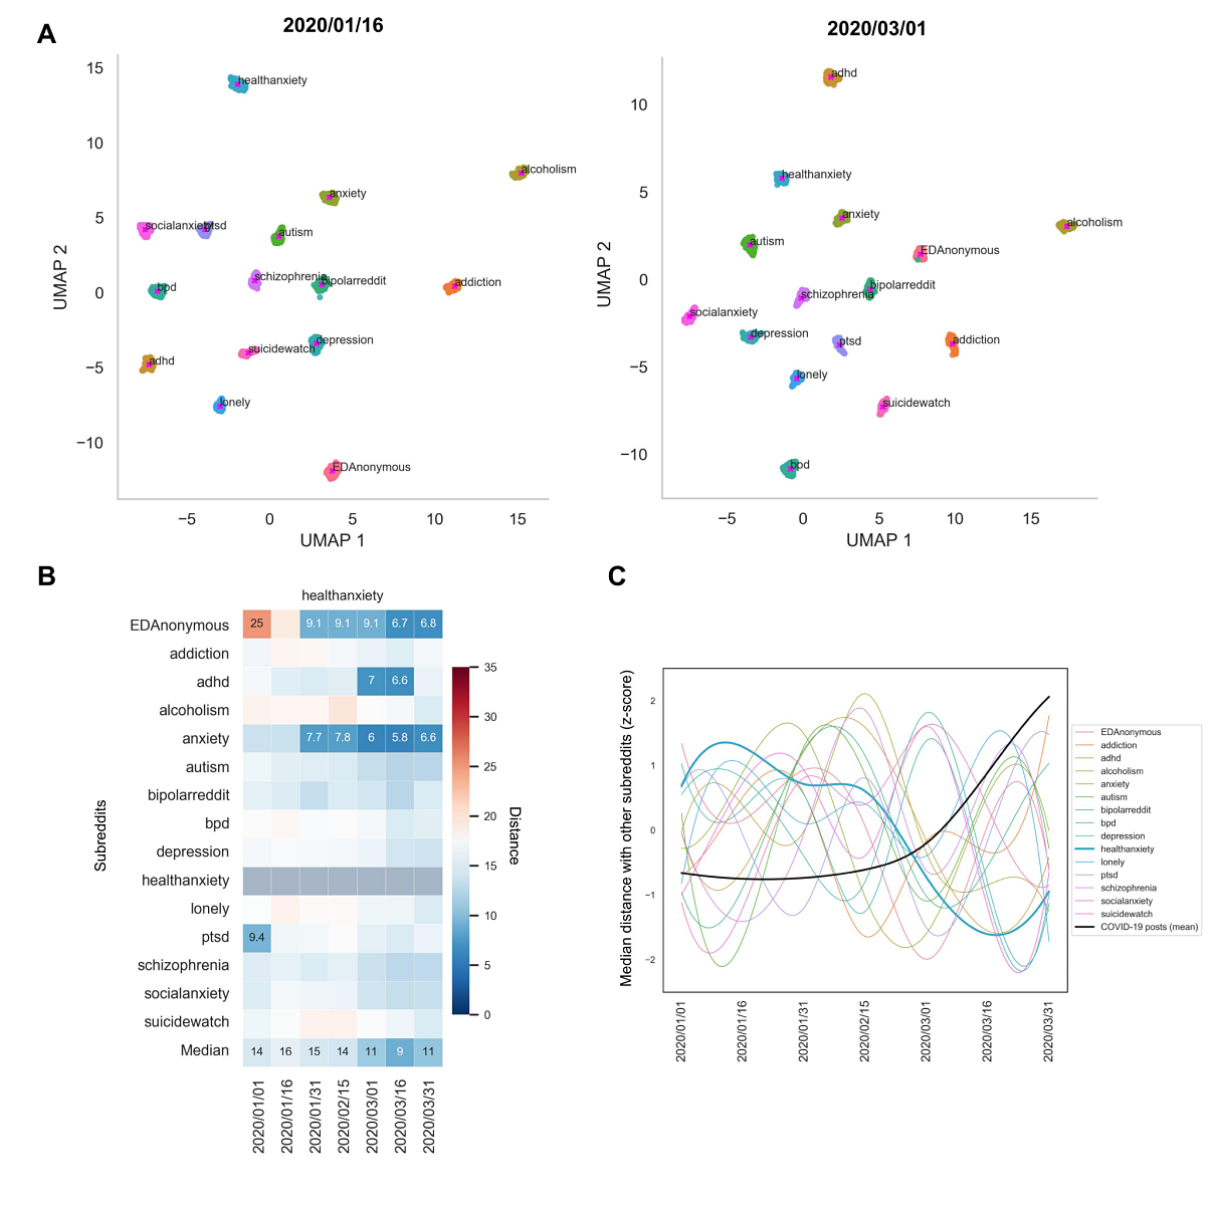
Figure 6. Supervised dimensionality reduction to measure how certain subreddits are becoming more or less similar over time. A) Supervised dimensionality reduction of posts within 15-day time windows with starting day displayed (r/healthanxiety becomes more similar to other subreddits). B) Median pairwise distance with r/healthanxiety for each time window over 50 bootstrapping samples displaying only extreme values with regard to normal 2019 fluctuations (top and bottom 5th percentiles), which indicates they are less likely to be part of normal fluctuations in distance. C) The median distance across all subreddits (last row in B) shows subreddits becoming more similar to r/healthanxiety during the increase in COVID-19–related posts (Figure 2 mean values were split into 7 time windows to match subreddit trends, and the mean was taken for each window). r/healthanxiety is the only trend that significantly correlates with COVID-19 posts after Benjamini-Hochberg multiple comparison correction ( ρ =–0.96, P <.001). adhd: attention-deficit/hyperactivity disorder; bpd: borderline personality disorder; EDanonymous: Eating Disorders Anonymous; ptsd: posttraumatic stress disorder; UMAP: Uniform Manifold Approximation and